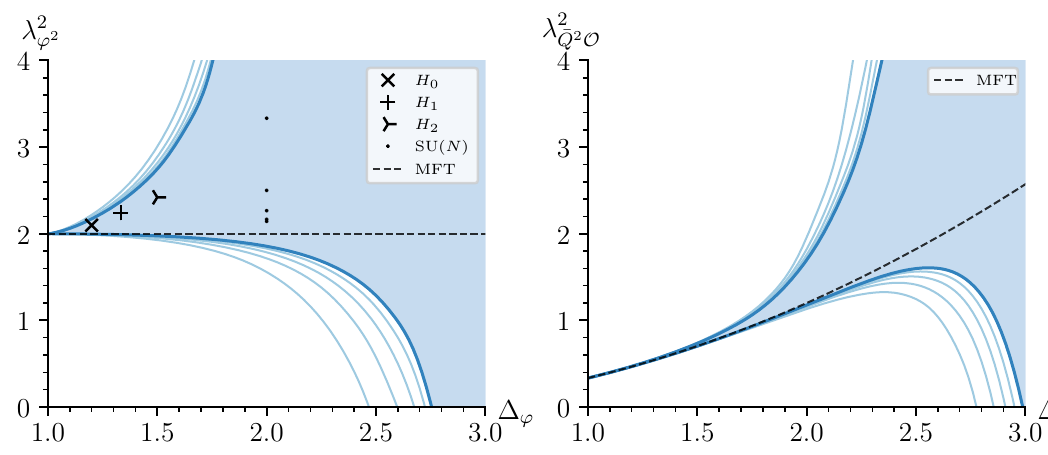
Figure 1 . Upper and lower bounds on the OPE coefficients of operators ϕ 2 and ¯ Q 2 O in ϕ × ϕ , where ϕ is the highest weight of a chiral multiplet. Curves are shown for Λ = 16 , 20 , 24 , 28 , 32 , and the allowed region is filled. In the left figure, the values for the rank one H 0 , H 1 and H 2 theories were computed in the large r -charge limit in [15, 16]. We also present free SU( N ) gauge theory values for N = 2 , . . . , 6 , which as N → ∞ approach the mean-field theory solution